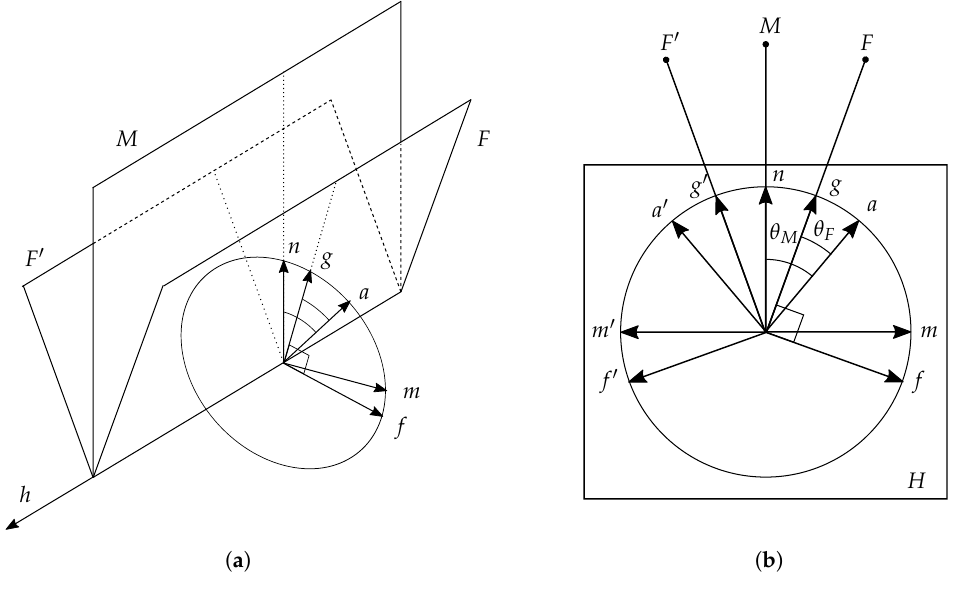
Figure 3. Face planes F and F (cid:48) symmetric across a mirror plane M , shown ( a ) obliquely and ( b ) directly from the + h direction. They share a common vector h , and have normals f and f (cid:48) . The plane normal to h is H , which contains a number of auxiliary vectors. For visual clarity, the bivectors are shown enlarged, but are understood to have unit